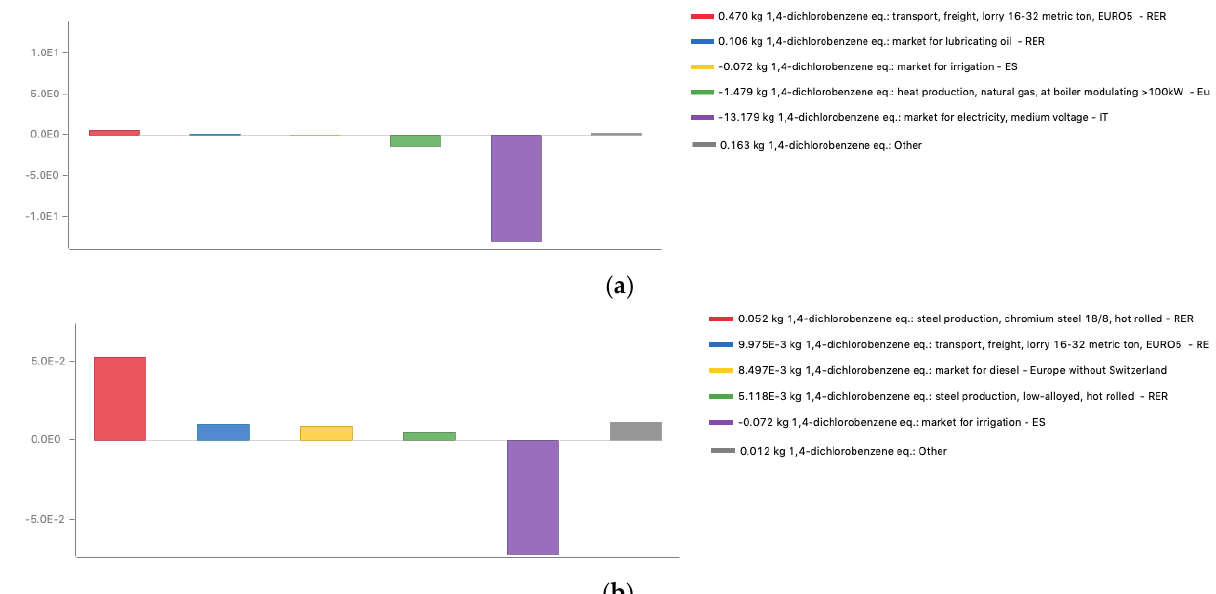
Figure 13. Terrestrial ecotoxicity: top 5 contributions impacting category results: ( a ) Cradle-to-grave analysis; ( b ) Downstream process.